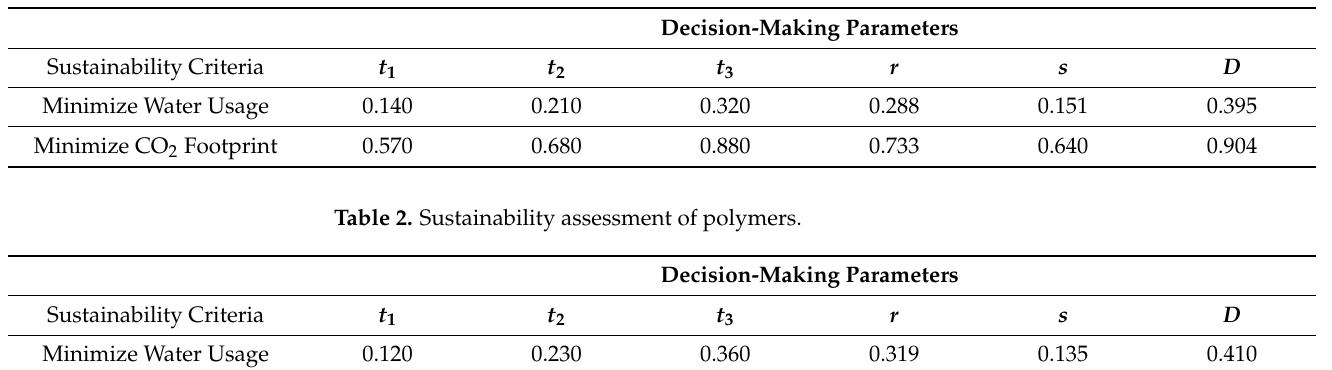
Figure 9. Extracted ranges representing water usage of wooden materials.